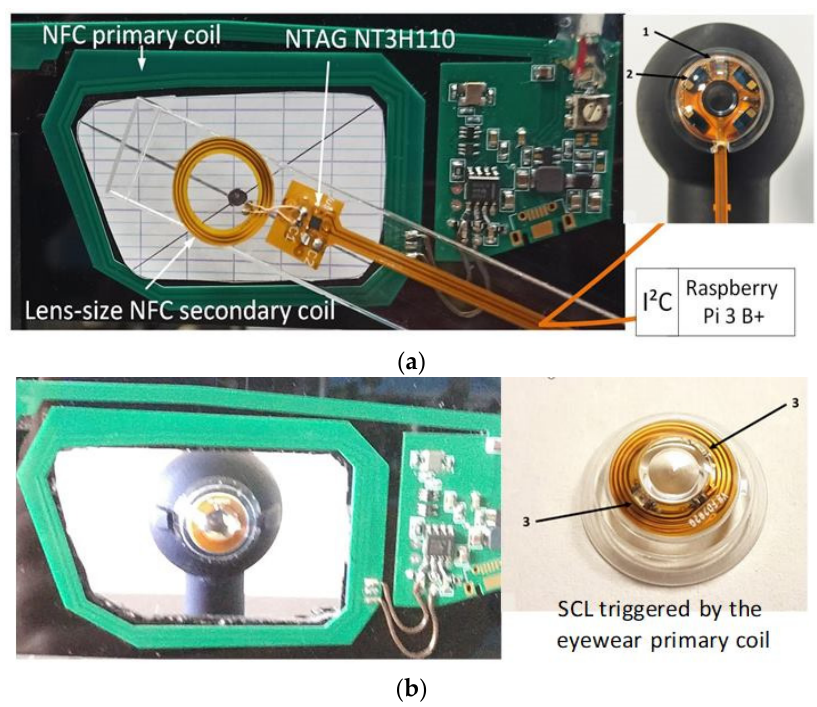
Figure 1. SCL with the eyewear: ( a ) SCL encapsulating four photodiodes (1), an ASIC and a communication module (2); ( b ) SCL encapsulating two VCSELs (3) used as a laser pointer.